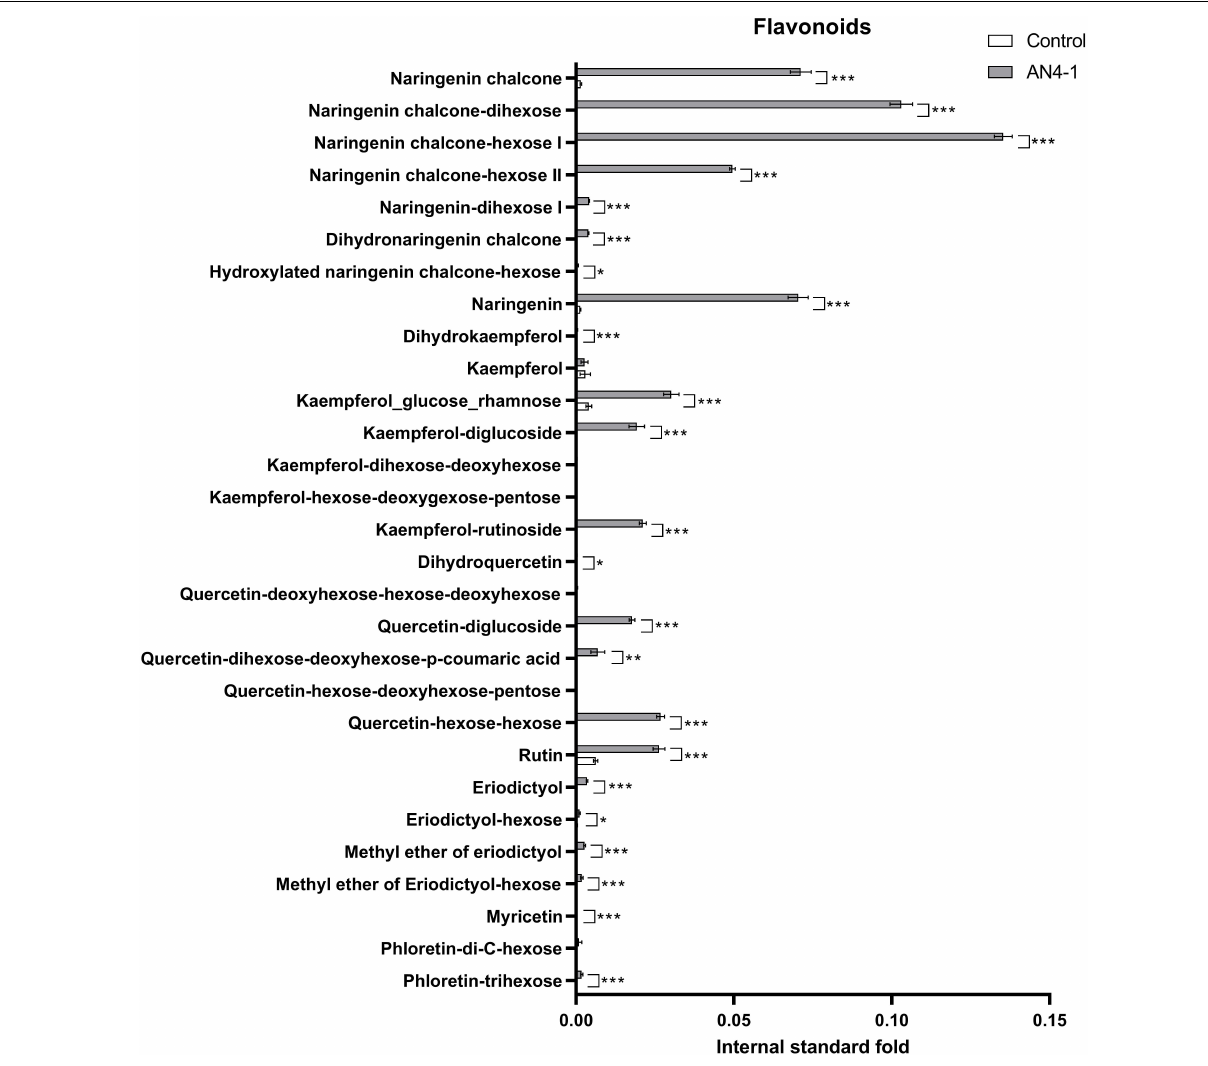
FIGURE 4 | Flavonoids are expressed as internal standard (formononetin) fold of control and AN4-1 HRCs. Columns report average values ± SD ( n = 3). * p -value ≤ 0.05, ** p -value ≤ 0.01 and *** p -value ≤